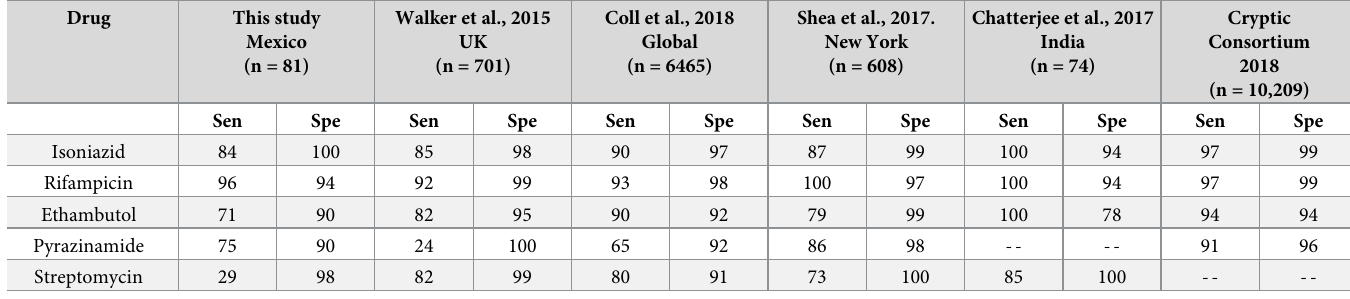
Table 7. Comparison of percentage of concordance values for drug resistant diagnosis prediction obtained by WGS found in this and several other studies.